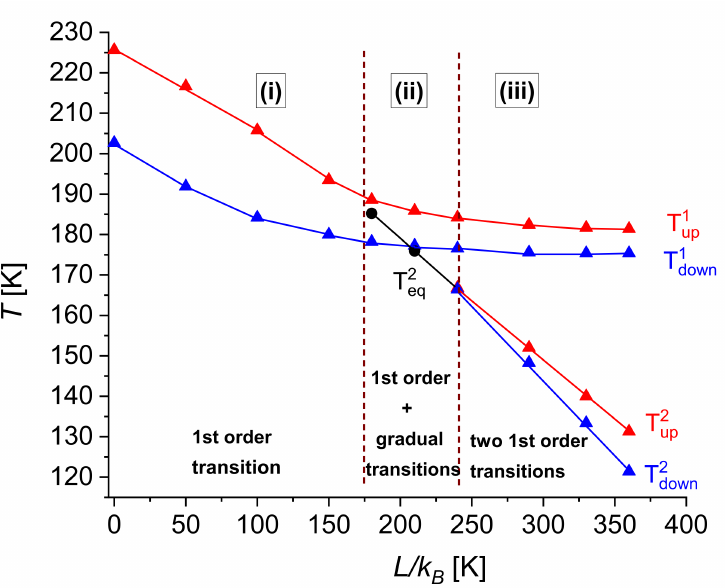
Figure 6. Phase diagram T versus ( L/k B ) for a 2D 6 × 6 square-shaped system. The red and blue triangles correspond, respectively, to the upper and lower transitions for the heating ( T up ) and cooling ( T down ) temperatures of the thermal HS fraction. The black circles correspond to the equilibrium tem- perature ( T eq ) of the gradual transition. The calculation parameters are: ∆ / k B = 1300 K, G / k B = 172 K, J bb / k B = 60 K, J ss / k B = 50 K, J bs / k B = 20 K and ln( g ) = 6.01.